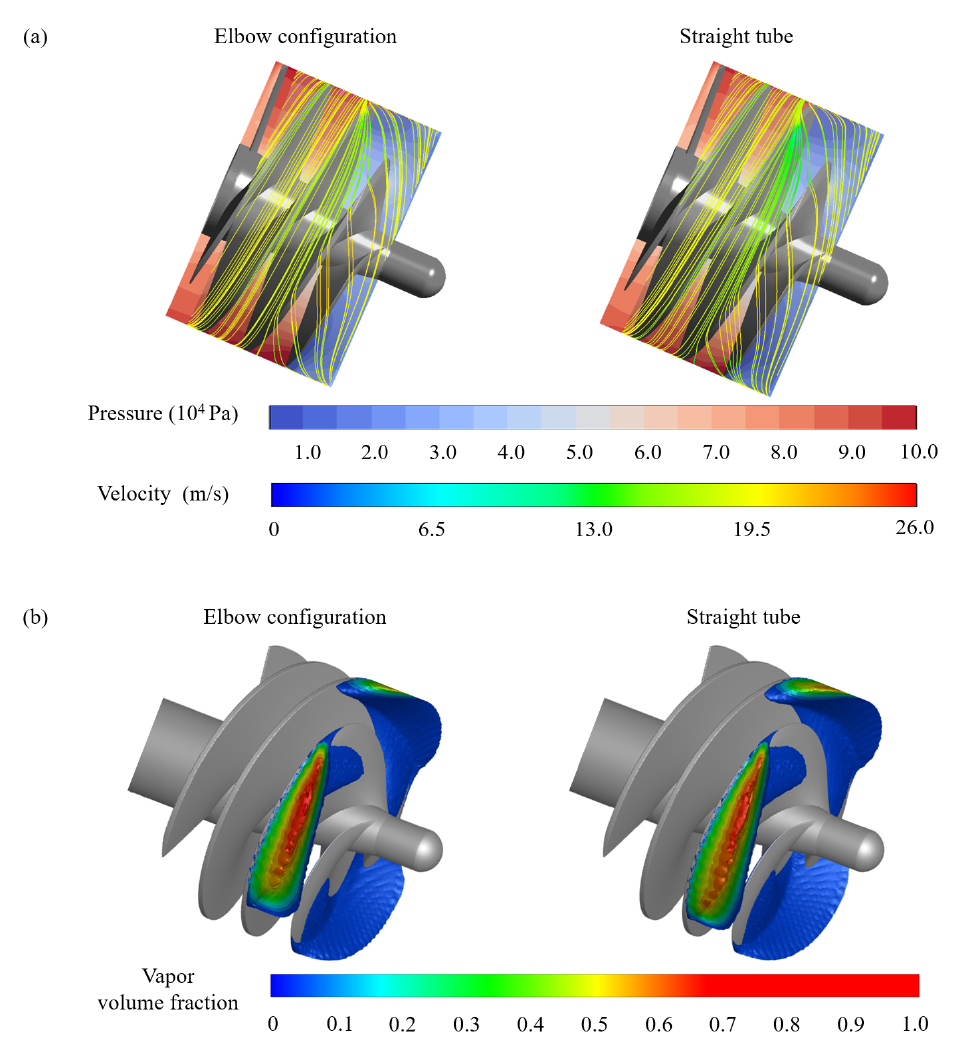
Figure 6. Steady numerical results between the elbow configuration and the simplified straight tube with the same tip clearance of 0.5 mm: ( a ) flow field (pressure distribution on the axial section plane, streamlines with the velocity magnitude) and ( b ) cavity structure with a vapor volume fraction of 0.3 on the blade